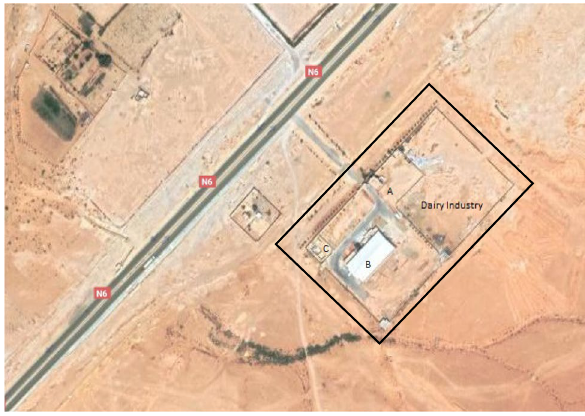
Fig. 1 Satellite view of location and structure of the studied dairy industry (Ouakda-Bechar, Southwest of Algeria) (Google maps 2020). A administration block; B manufacturing workshop; C basin for collection and disposal of the dairy